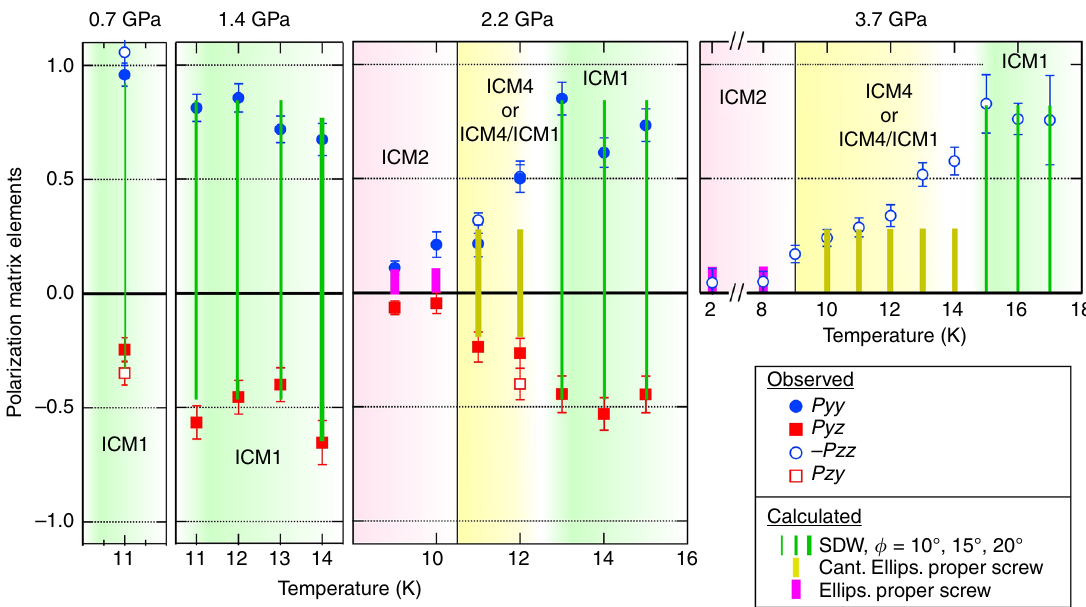
Fig. 5 Polarization matrix elements data at several pressures. Temperature dependence of the polarization matrix elements for 0, − q , − 1/2 re fl ection, P yy ( fi lled circles), P yz ( fi lled squires), − P zz (open circles) and P zy (open squires) at P = 0.7, 1.4, 2.2, and 3.7 GPa. The vertical bars represent the calculated values: the spin-density-wave structure with φ = 10°, 15°, 20°, the canted ellipsoidal proper screw with 0.60 ellipsoidal ratio and 5° canting angle and ellipsoidal proper screw with 0.92 ellipsoidal ratio. Note that we cannot distinguish a single ICM4 phase from coexistence of ICM4 and ICM1 phases for the intermediate temperature regions at 2.2 and 3.7 GPa in the present experiment, as indicated by ICM4 or ICM4/ICM1. The solid lines denote the phase transition temperatures between ICM2 and